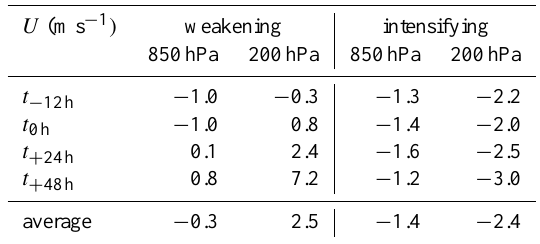
significant test at Y Y Y Y Y Y 95% confidence level * The symbols “M” and “D” indicate the magnitude and direction of the vertical wind shear, respectively. A wind coming from the south is given as 180 ◦ and one from the east is 90 ◦ .